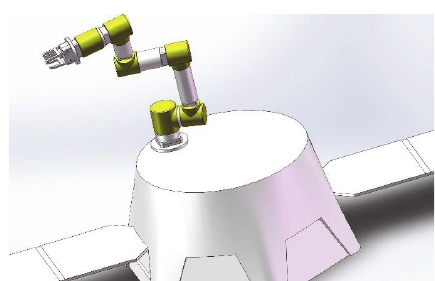
Figure 3: A space-based, 6-DOF manipulator